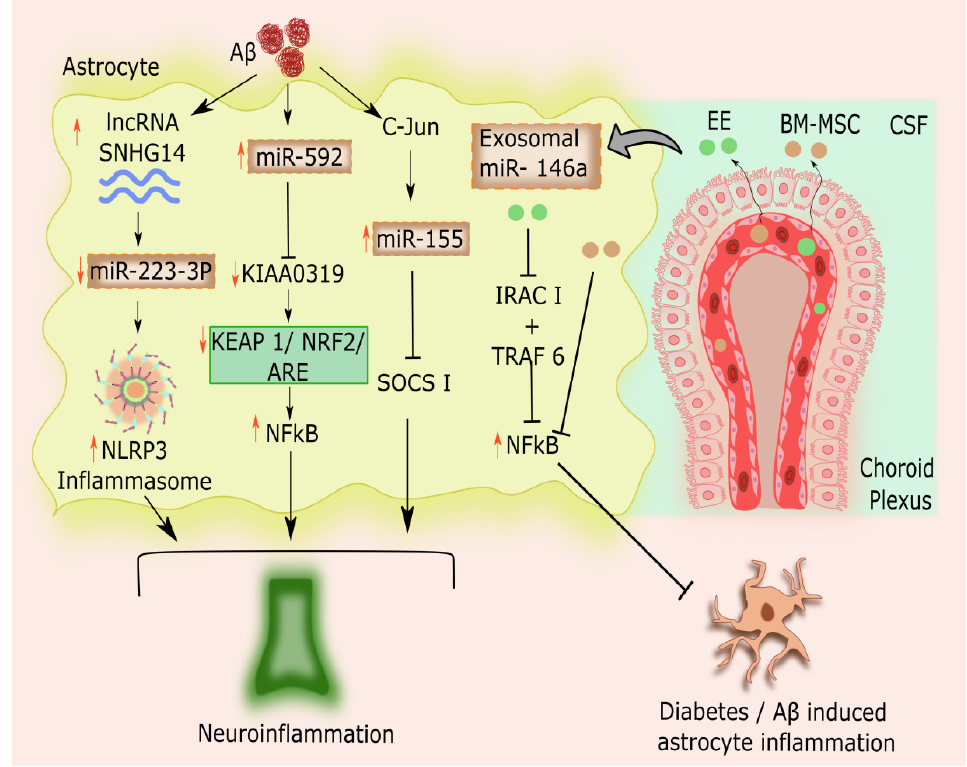
Figure 3. Astrocytic microRNAs-long non-coding RNA interconnection in astrocytic inflammation Alzheimer's disease. EVs released from the CP into the CSF during EE and treatment with BM-MSCs reach astrocytes, where both EE and BM-MSCs protect against A β and diabetes-induced astrocyte inflammation through the elevation of miR-146a and concurrent reduction in NF- κ B. EVs produced by EE mainly work by inhibiting IRAK1 and TRAF6, which lower NF- κ B. In A β -activated astrocytes, levels of c-Jun and miR-155 were both noticeably increased, which in turn inhibited SOCS-1. miR-155 levels are decreased by c-Jun silencing, which also protects against neuroinflammation-induced AD. miR-592 expression was increased and KIAA0319 levels were lowered in AD rat models, which further activated KEAP1 and inhibited NRF2 signaling, leading to an increase in NF- κ B expression. Additionally, miR-592 suppression activates KEAP1/NRF2/ARE pathways, which in turn reduces neuroinflammation and astrocyte damage brought on by oxidative stress. Finally, after exposure to A β , lncRNA, SNHG14 was elevated and miR-223-3p levels were lowered. Astrocytic miR-223-3p directly targets NLRP3 and reduces miR-223-3p expression further activating the NLRP3 inflammasome, which leads to neuroinflammation and AD. miR-223-3p levels were significantly elevated, and AD was prevented by SNHG14 knockdown. A β : Amyloid beta; SOCS-1: Suppressor of cytokine signaling 1; CP: Choroid plexus; CSF: Cerebrospinal fluid; EE: Environmental enrichment; NF- κ B: Nuclear factor- κ B ; TRAF6: Tumor necrosis factor receptor-associated factor 6; IRAK1: Interleukin-1 receptor-associated kinase 1; BM-MSCs: Bone marrow mesenchymal stem cells; KEAP1: kelch-like ECH-associated protein 1; NRF2: Nuclear factor erythroid 2-related factor 2; ARE: Antioxidant response element; KIAA0319: Dyslexia-Associated Protein; lncRNAs: Long non-coding RNA; MEG3: Maternally expressed gene 3; NLRP3: NLR family pyrin domain containing 3; SNHG14: Small nucleolar RNA host gene